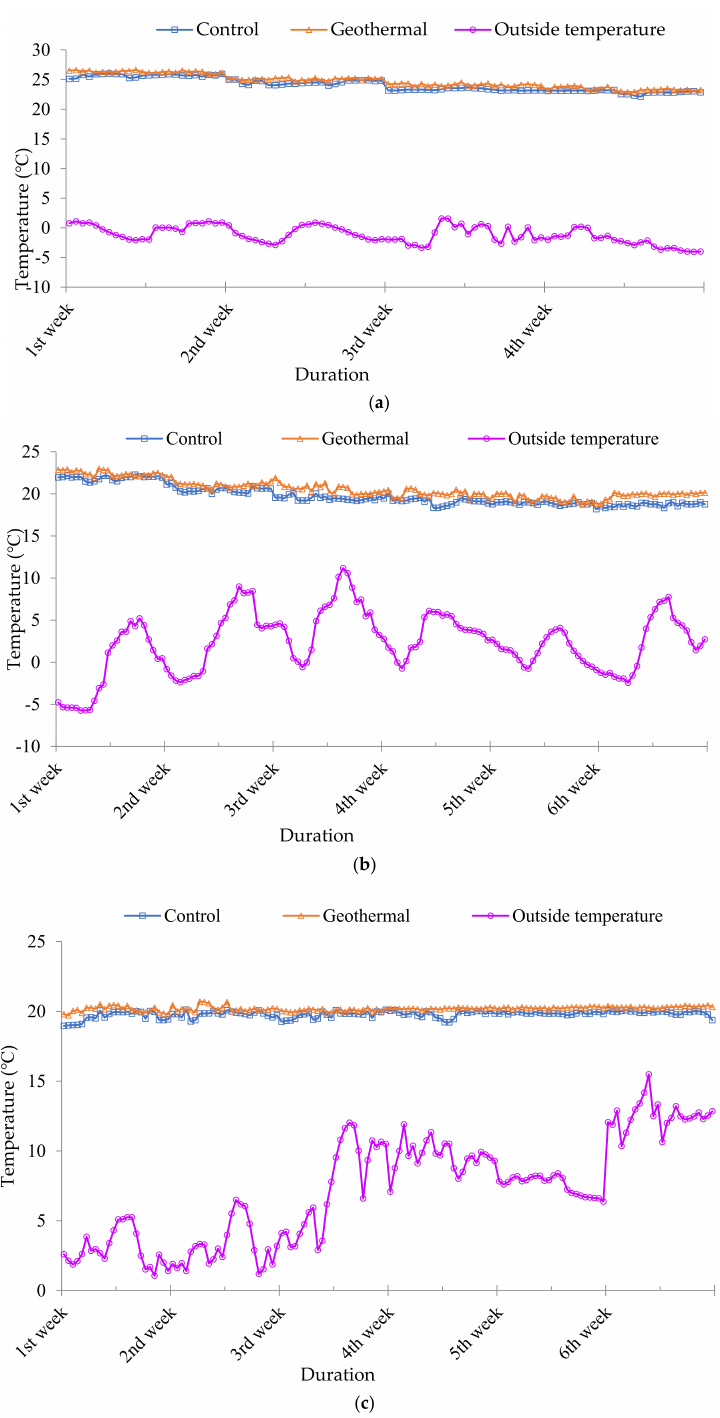
Figure 4. Temperature of the control pig house and geothermal heat pump connected pig house during the experiment. ( a ) Weaning period; ( b ) growing period; ( c ) finishing